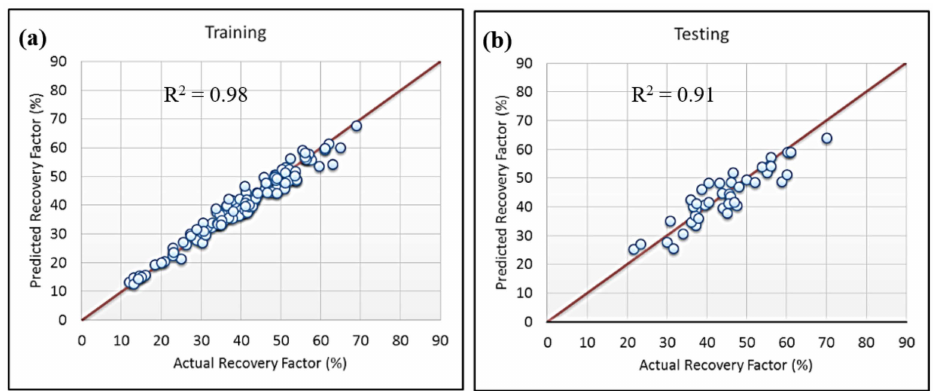
Figure 4. Predicted vs. actual recovery factor based on adaptive neuro-fuzzy inference system with subtractive clustering (ANFIS-SC) model ( a ) training dataset, ( b ) testing